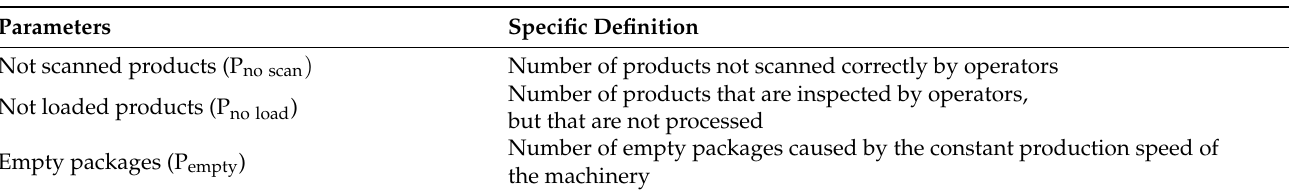
Table 6. Definition of metrics used for the OEE evaluation methodology for a semi-automatic packaging machine. Parameters Specific